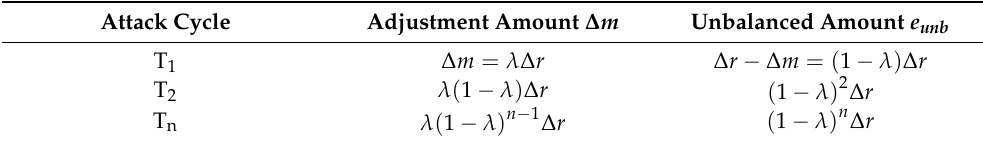
Table 1. Fake data injection attacks accumulate an imbalance. Attack